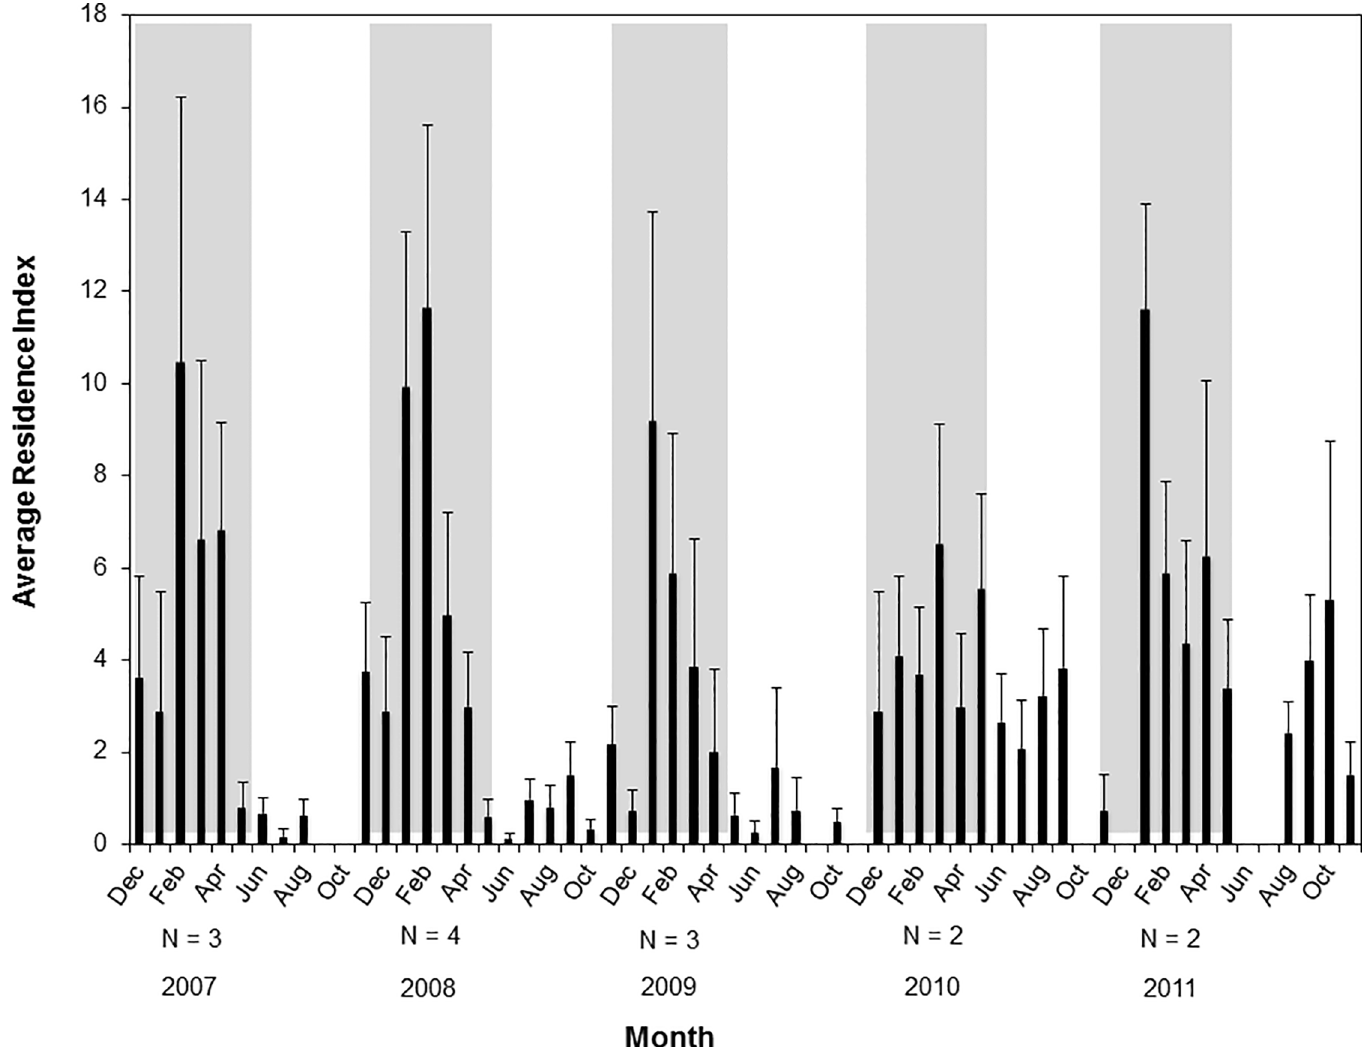
Fig 6. Average Residence Index for lemon sharks at the FSA site during grouper spawning season (gray) and non-spawning season (white) between 2007 – 2011. Sample size indicates the number of sharks detected each year. Bars represent mean and standard error.